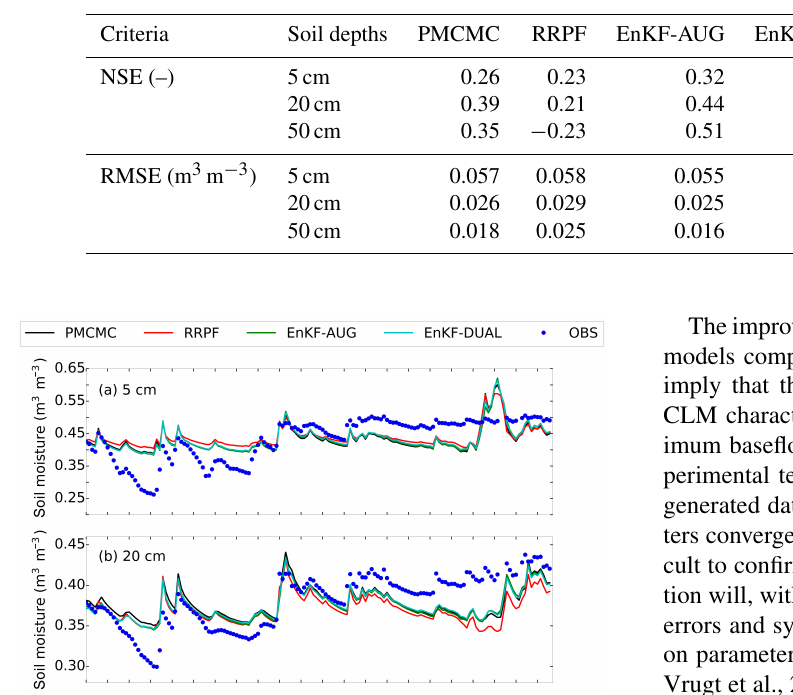
Table 9. Evaluation period: NSE and RMSE values for the Rollesbroich soil moisture measurements at 5, 20, and 50cm depths using CLM. The initial states and parameter values used by the PMCMC, RRPF, EnKF-AUG, and EnKF-DUAL data assimilation methods originate from the 5-month calibration data period. For completeness, we also list the performance of the EnKF using state estimation (noParamUpdate) using CLM parameter values drawn randomly from the prior parameter distribution, and the performance of an open-loop run of CLM (OpenLoop) using the mean simulation of many different CLM parameterizations drawn randomly from the prior parameter distribution.